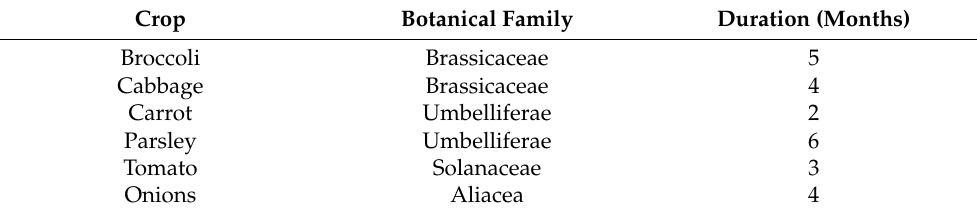
Table 8. Sample of the crops used in Scenario 2 with their botanical family and cultivation